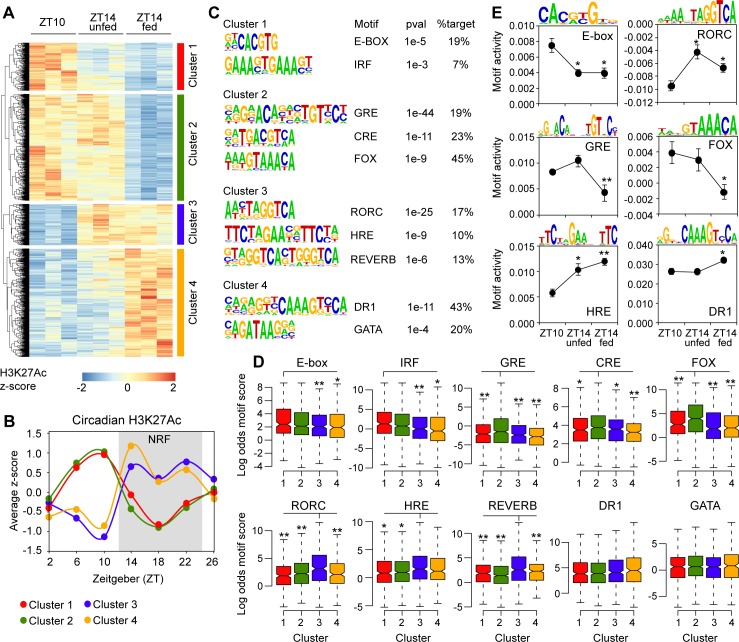
Enriched DNA motif analysis within DHSs associated with differentially regulated H3K27Ac.(A) DHSs differentially H3K27 acetylated at ZT14-fed compared to ZT10 was identified at FDR < 0.1 (n = 3). At these DHSs, H3K27Ac was quantified in livers from three biological replicates at ZT10, ZT14-unfed, and ZT14-fed. H3K27Ac tag count is visualized as z-scores. Hierarchical clustering reveals four distinct clusters. (B) Circadian H3K27Ac of DHSs associated with clusters 1–4. Circadian H3K27Ac ChIP-seq data is from livers of NRF animals [16], and the tag count is normalized to a z-score. The average z-score for each cluster is plotted as a function of time. (C) DNA motif analysis of DHSs associated with clusters 1–4. (D) Quantification of the log odds motif score for each motif in DHSs associated with clusters 1–4. Statistical significance is calculated using Kruskal–Wallis test followed by a posthoc pairwise Mann–Whitney–Wilcoxon Test. The Kruskal–Wallis p-value is less than 0.05 between clusters for all motifs except DR-1 and GATA. (E) Activity of selected motifs calculated using IMAGE [26]. Data are presented as mean ± SEM (n = 3). Statistical significance is calculated using Student t test. *p < 0.05 and **p < 0.005. Numerical values for panels A, B, D, and E are available in S3 Data. DHS, DNase hypersensitive site; DR-1, direct repeat; FDR, false discovery rate; H3K27Ac, histone 3 lysine 27 acetylation; IMAGE, integrated analysis of motif activity and gene expression; NRF, night-restricted fed.